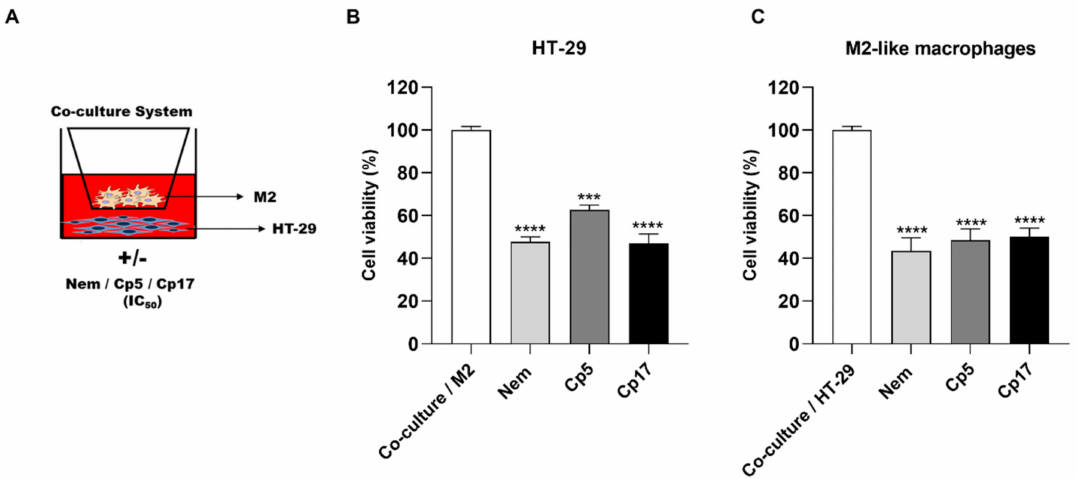
Figure 5. E ff ect of Nem, Cp5 or Cp17 (concentrations used, 24 µ M, 50 µ g / mL, 25 µ g / mL, respectively) in co-cultures ( A ) on the viability of HT-29 ( B ) and M2-like macrophages ( C ). *** p < 0.001, **** p < 0.0001 vs. untreated